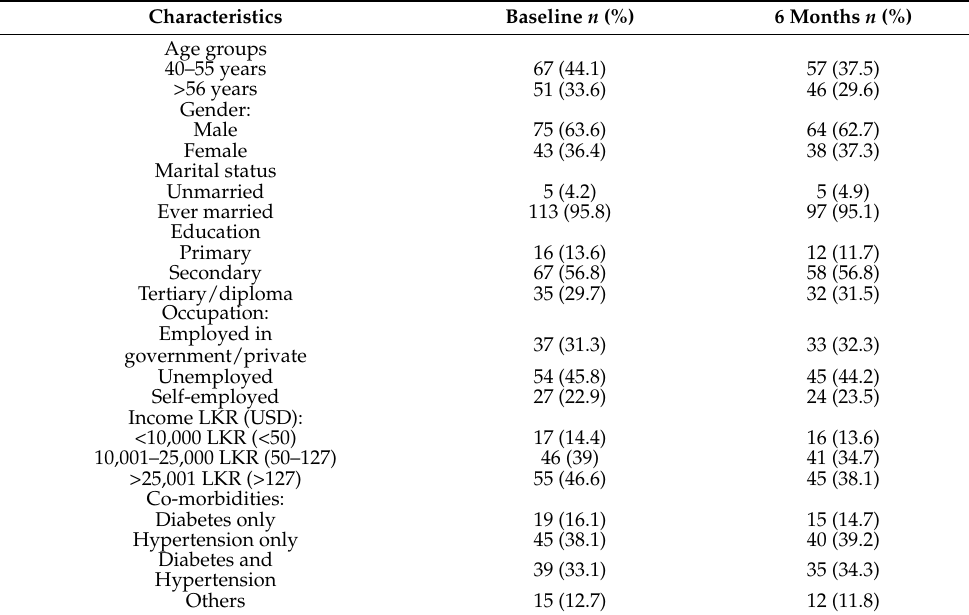
Table 1. Socio-demographic characteristics of study participants at baseline ( n = 118) and at 6 months ( n =